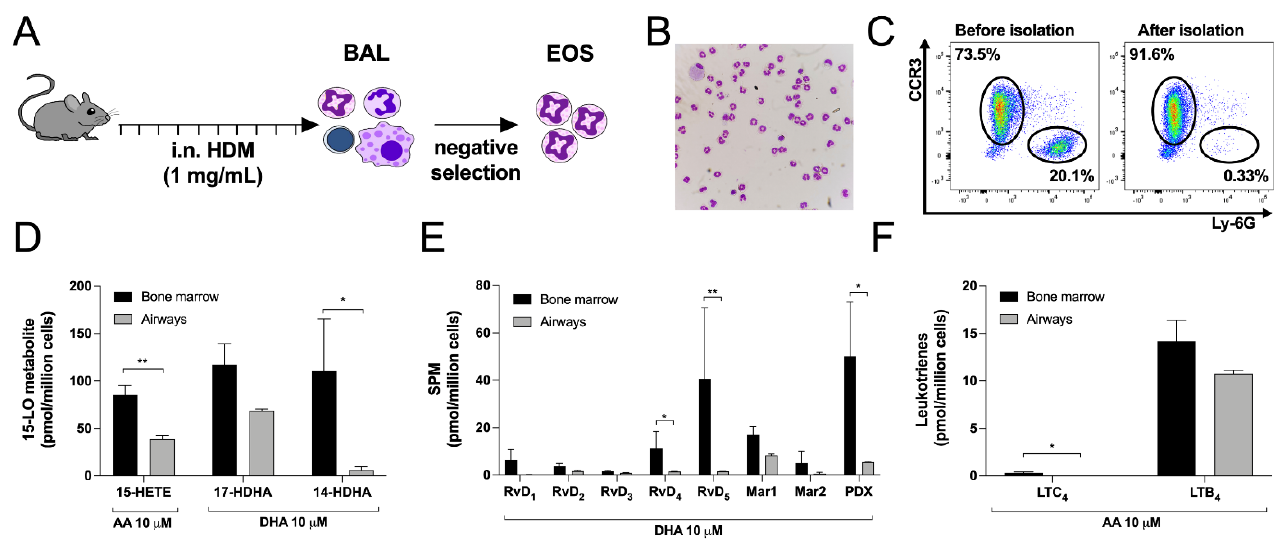
Figure 7. Comparison between eosinophils isolated from the airways of HDM-treated mice and eosinophils derived from the bone marrow. ( A ) Experimental design to isolate mouse eosinophils from the airways of HDM-treated mice. ( B ) Morphology of airway cells after eosinophils enrichment determined by DiffQuik staining. ( C ) Purity of airway EOS before and after negative selection. ( D – F ) Eosinophils (5 × 10 6 cells/mL, 37 °C) were treated with ( D ) 10 µM AA or 10 µM DHA and ( E ) 10 µM DHA or ( F ) 10 µM AA for 15 min. Incubations were stopped by adding one volume of cold ( −20 °C) MeOH containing the internal standards. Samples were processed and analyzed for eicosanoids and docosanoids content by LC-MS/MS, as described in Materials and Methods. Results are the mean (± SEM) of 7 independent experiments using bone marrow-derived mouse eosinophils and 4 independent experiments using mouse eosinophils isolated from the airways. Data from bone marrow derived eosinophils are the same as those presented in Figures 1, 3 and 5. p -values were obtained as described in Materials and Methods. * p < 0.05, ** p < 0.01.